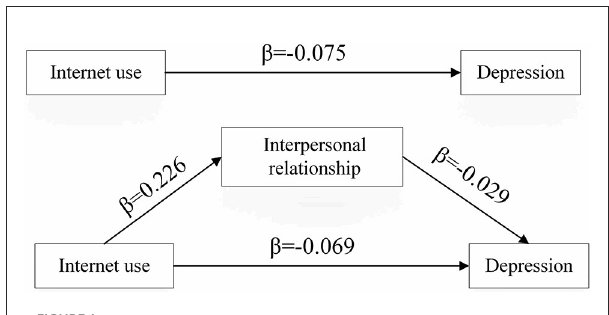
FIGURE1 Mediating effects of interpersonal relationship in the association between Internet use and depression.